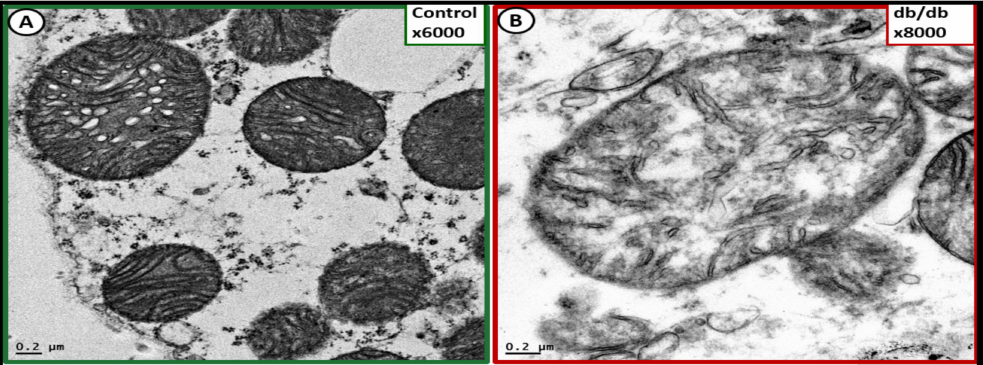
Figure 26. Comparison of healthy mitochondria in controls to aberrant mitochondria (aMt) in remodeled transdifferentiated white adipose tissue of the descending aorta of the obese diabetic db/db model. Panel A demonstrates the electron-dense mitochondria (Mt) in the control model and note the prominent crista and the electron-dense Mt matrix. Panel B depicts the hyperlucent Mt with loss of the electron-dense Mt matrix and incomplete formation and loss of crista. This aMt would be leaky of ROS—superoxide and result in a dysfunctional PVAT that is known to be associated with aortic stiffening in db/db models. Importantly, this highly magnified image applies to remodeling changes in the normal control Mt ( panel A ) to the aMt ( panel B ) as found in disease models in all the ultrastructure presented images. These figures are provided with permission from the experiment in reference [69]. Magnification × 6000 and × 8000; scale bar = 0.2 µ m in panels A and B